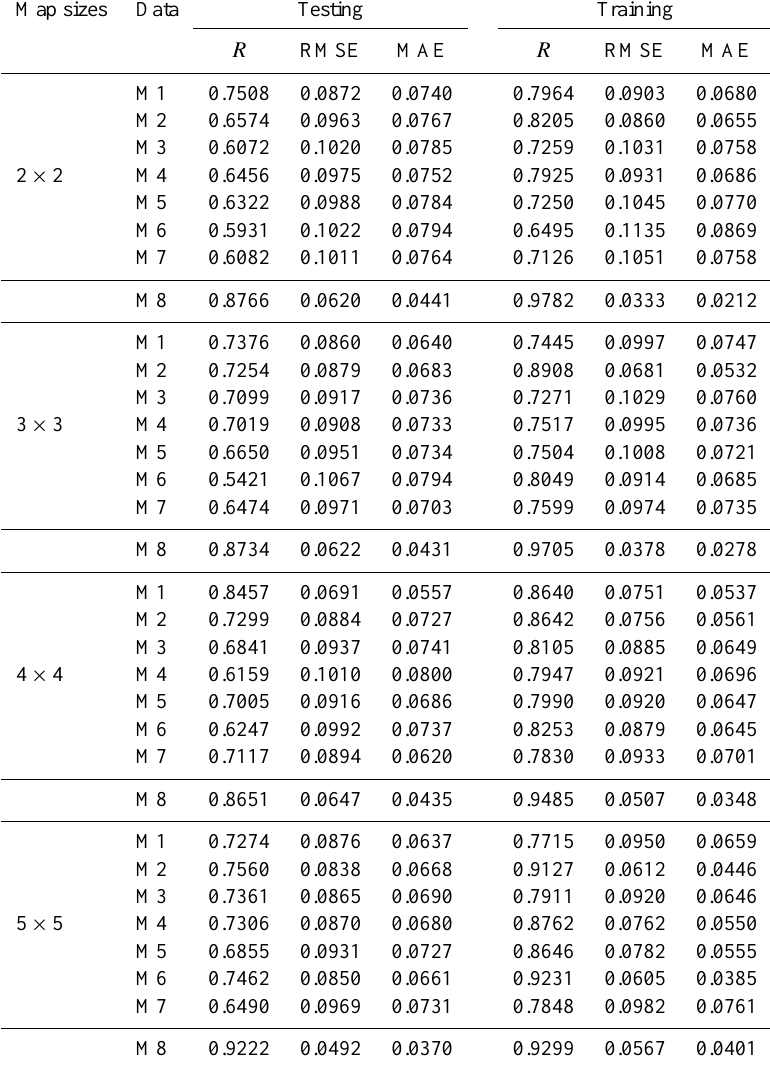
Table 1. The result for training and testing using a hybrid model of SOM-LSSVM for different map sizes (Ismail et al., 2012). Map